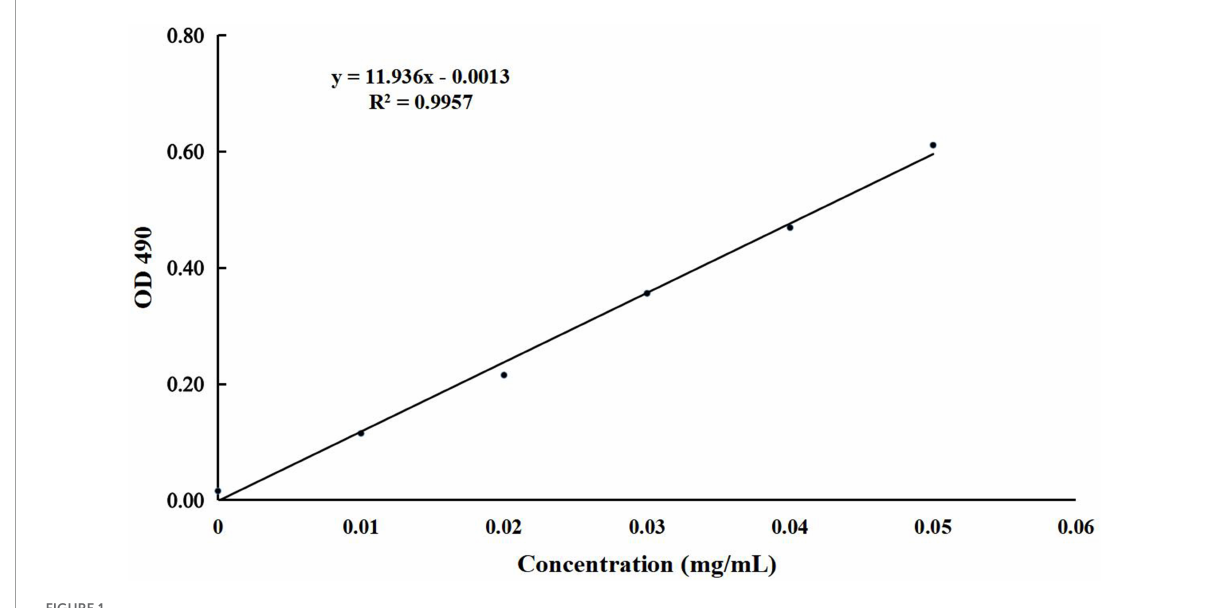
FIGURE1 The standard curve of glucose used for detecting the concentration of BLBP.